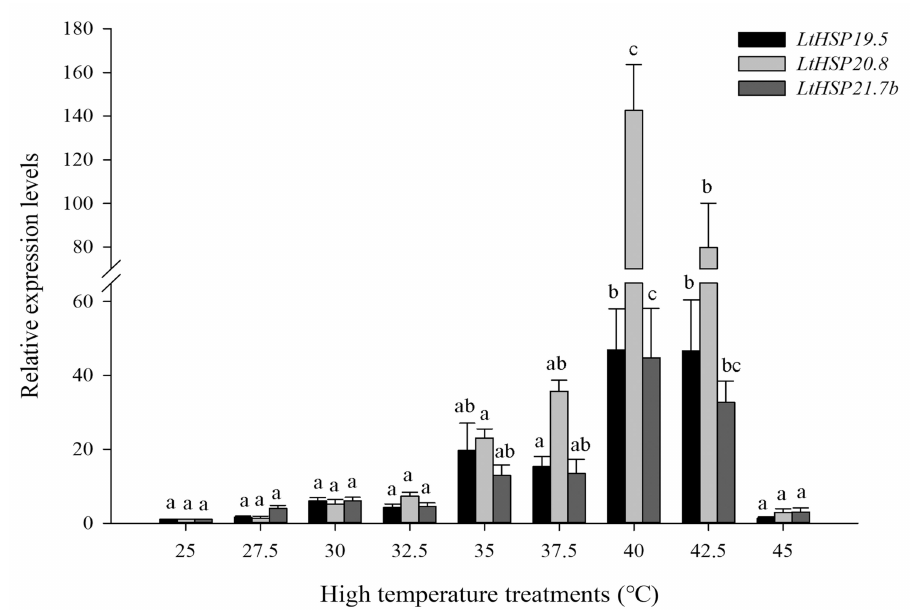
Figure 5. Relative expression levels of LtHSP19.5, LtHSP20.8, and LtHSP21.7b under high temperature treatments. The relative level of HSP expression represented the fold increase as compared with the expression in controls. The data were denoted as mean ± SE. One-way analysis of variance (ANOVA) was used to analyze the relative expression levels of three sHSPs under high temperature treatments. For the ANOVA, data were tested for homogeneity of variances and normality. Di ff erent lowercase letters indicate significant di ff erences among di ff erent temperature treatments. Tukey’s multiple range test was used for pairwise comparison for mean separation ( P < 0.05).